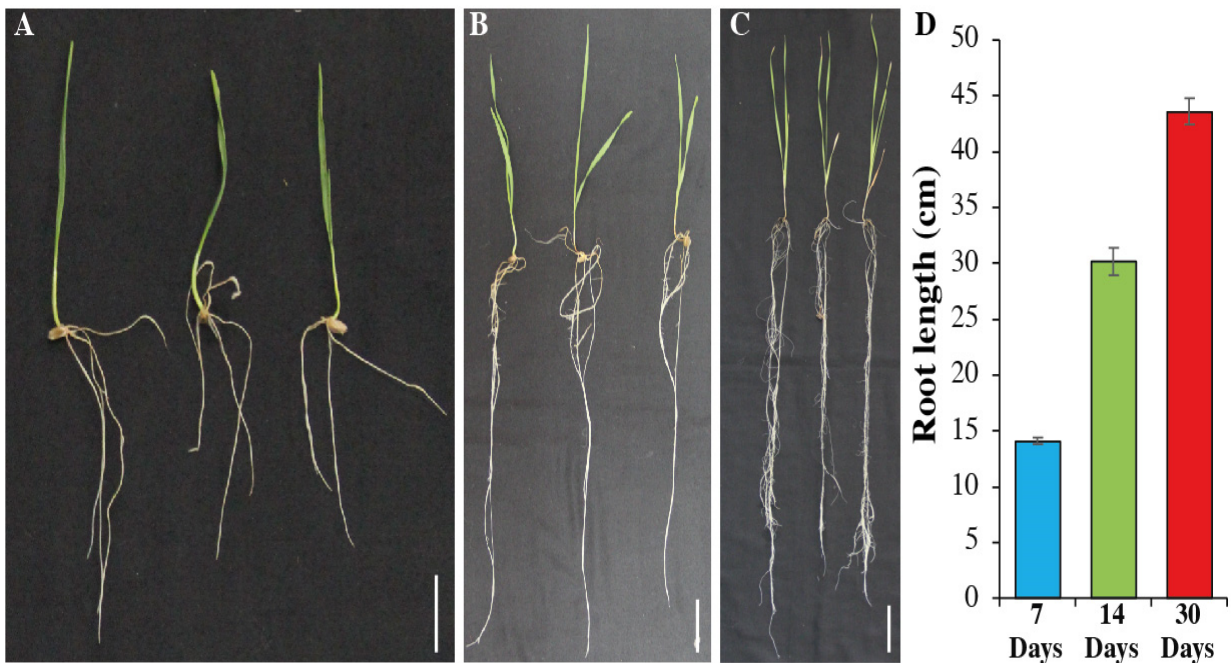
Figure 1. Root length of wheat seedlings at three different points. Seedlings at 7 days ( A ), 14 days ( B ), and 30 days ( C ). Bars = 4 cm. Quantification of root length ( D ). Bars are the mean of three replications and standard deviation was used.